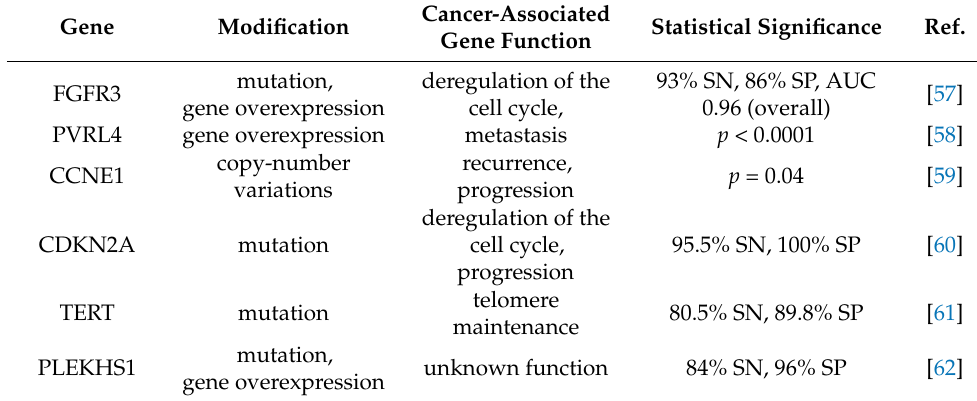
Table 2. The most promising DNA